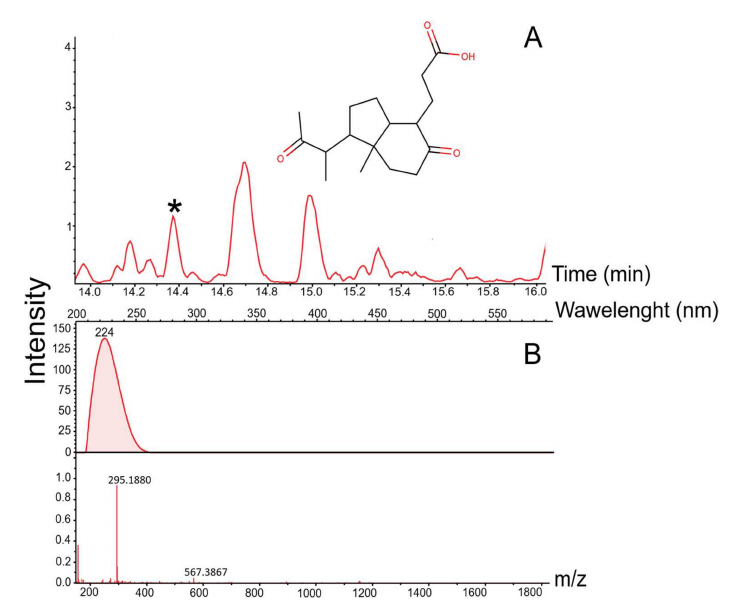
Figure 10. Mass chromatogram of the natural product identified as Octahydro-7 α -methyl-1- (1-methyl-2-oxopropyl)-5-oxo-1H-indein-4-propionic acid: ( A ) Chromatogram of Octahydro-7 α - methyl-1-(1-methyl-2-oxopropyl)-5-oxo-1H-indein-4-propionic acid; ( B ) UV and mass profile of the peak identified as otahydro-7 α -methyl-1-(1-methyl-2-oxopropyl)-5-oxo-1H-indein-4-propionic acid. *-asterisk indicates peak of natural product.